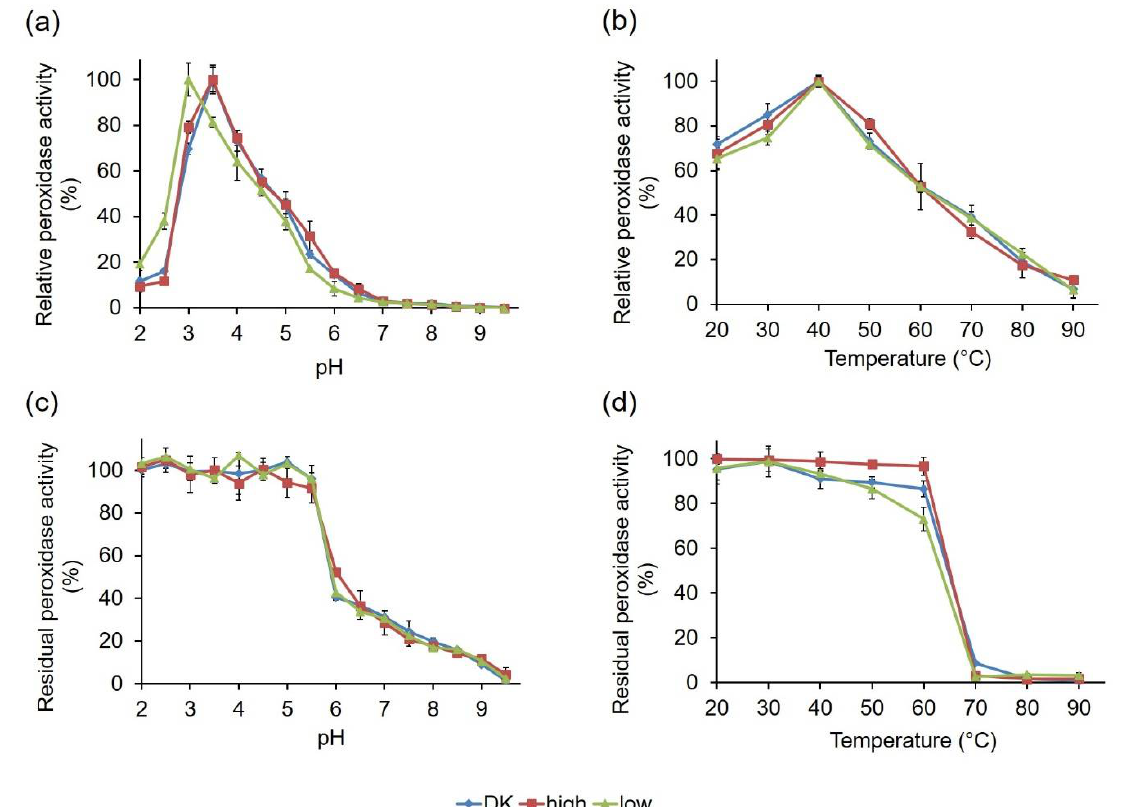
Figure 8. Influence of pH and temperature on activity and stability of the PsaPOX variants. ( a ) pH optimum and ( b ) temperature optimum. Relative peroxidase activity was defined as the percentage of activity detected with respect to the highest activity of the corresponding enzyme variant in each experiment. pH stability ( c ) was determined after incubation of PsaPOX in Britton–Robinson buffer, ranging from pH 2.0 to 9.5 for 1 h at RT, and temperature stability ( d ) was determined after incubation at 20–90 °C and pH 3.5 for 1 h. Residual activities were determined at pH 3.5 and 40 °C. Values are the average of triplicate experiments with standard deviations shown as error bars. DK: PsaPOX_DK; high: PsaPOX_high; low: PsaPOX_low.